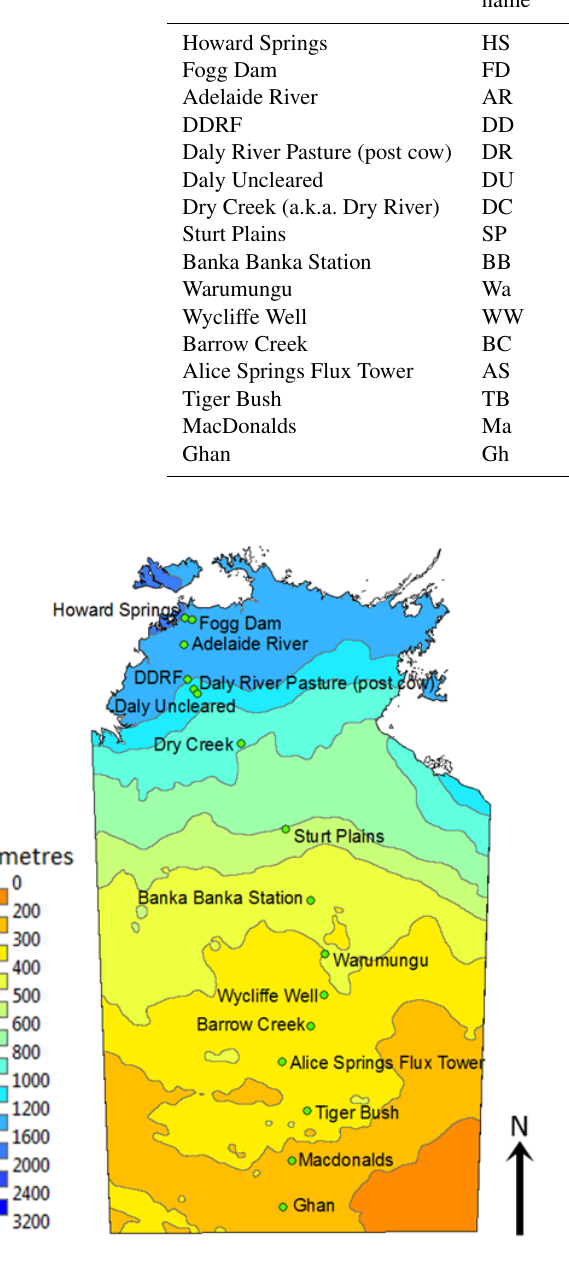
Figure 1: Map of average annual rainfall (mm) from 1961 to 1990 (colours) and the location of each site along the North Australian Figure 1. Map of average annual rainfall (mm) from 1961 to 1990 Tropical Transect (Adapted from Bureau of Meteorology (2011a)). (colours) and the location of each site along the North Australian Tropical Transect (adapted from Bureau of Meteorology,